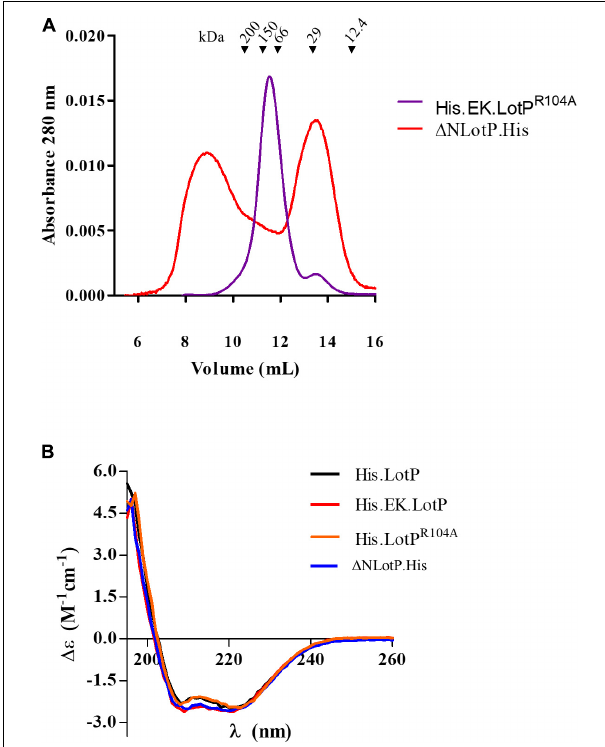
FIGURE 4 | Modifications to LotP and its effect on structure and dimerization. (A) Representative chromatogram of purified His.EK.LotP R104A (red) and (cid:49) NLotP.His (blue) analyzed by size-exclusion chromatography using a Superose 12 column. The purified proteins were separate according to its native molecular size. The elutions were monitored continuously at 280 nm, and the graphic shows the signal at the different elution volumes. (B) Purified His.LotP (black), His.EK.LotP (red), His.LotP R104A (orange), and (cid:49) NLotP.His (blue) proteins analyzed by far UV circular dichroism spectra. Each curve is an average of three scans, normalized by the mean residue weight of each proteins, path length, and protein concentration.